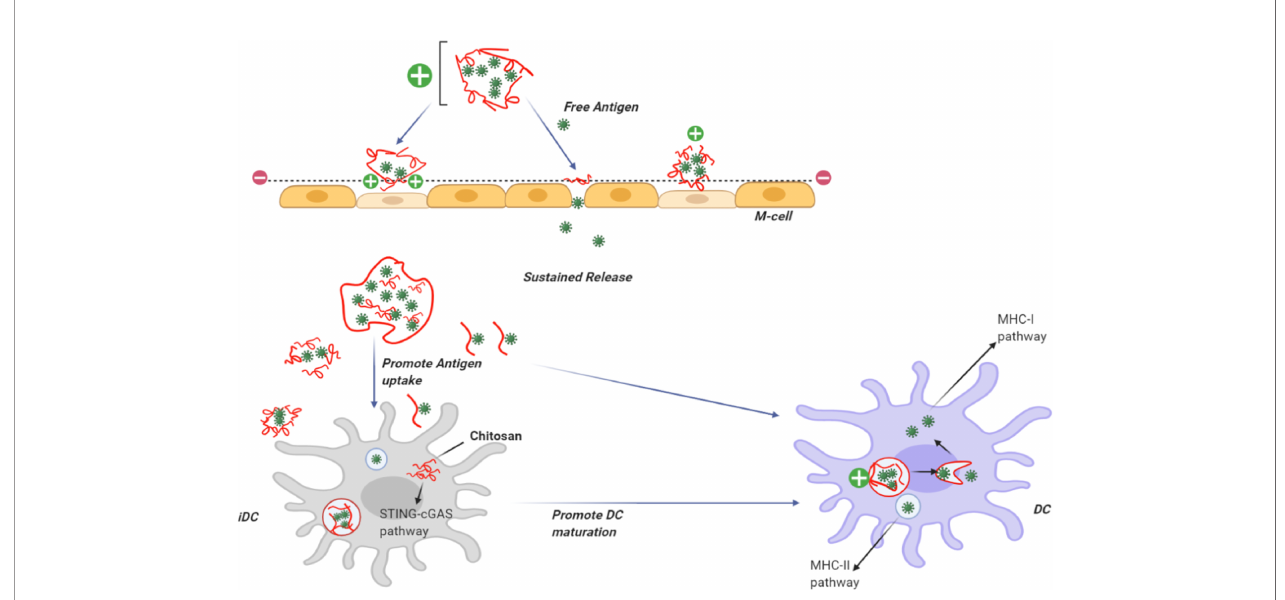
FIGURE 2 | Use of chitosan as an adjuvant for vaccine delivery. CH can be dissolved in acid to provide a positive charge on the particle surface. CH NPs containing antigens can adhere to the cell surface in the nasal mucosa giving a prolonged residence time. CH can open the tight junctions and allow the transfer of free antigens through the para-cellular route, as well as the transcytosis of the packaged antigens via M-cells. CH becomes insoluble at physiological pH, providing slow release of encapsulated antigens and uptake bydendritic cells DCs. Following uptake by DCs, CH activates the STING-cGAS pathway resulting in DC maturation. After the insoluble particles have been taken up by cells via endocytosis, CH becomes soluble at the acidic pH and the antigens escape from the lysosomes into the cytoplasm for cross presentation through the MHC-I pathway. Antigens taken up by DCs can berouted to the MHC-II